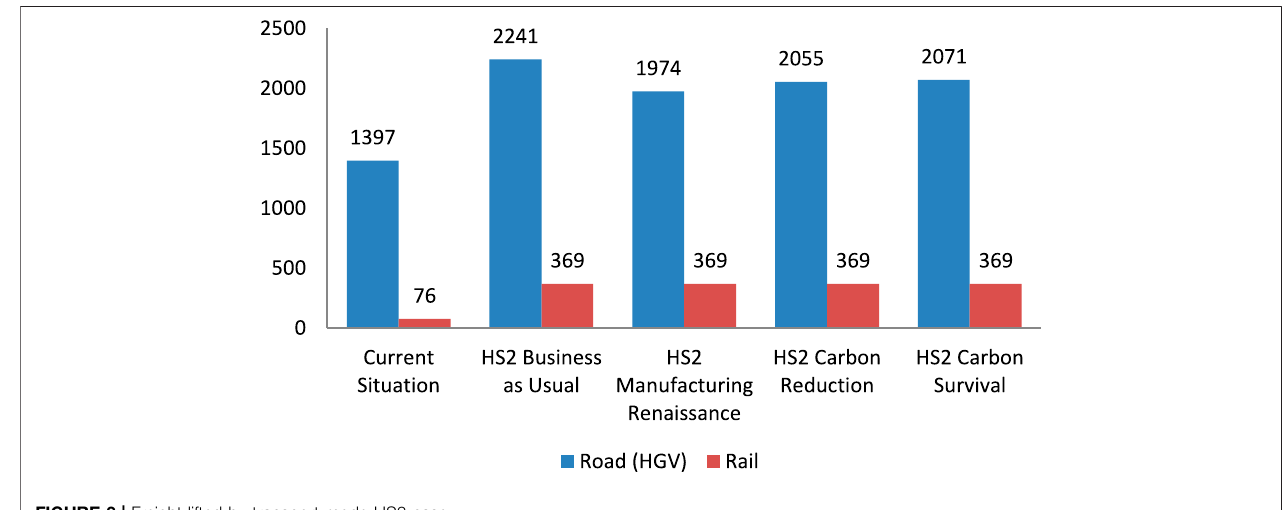
FIGURE 3 | Freight lifted by transport mode HS2